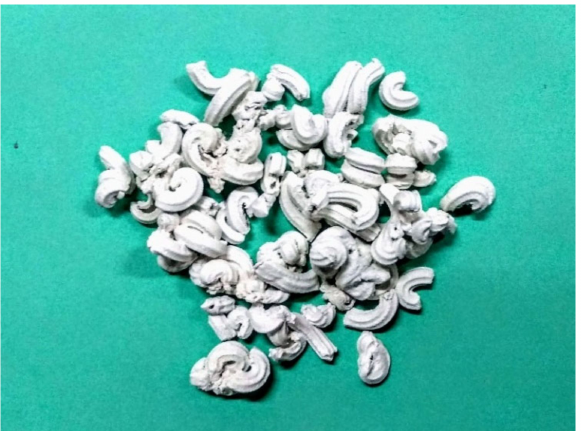
Figure 1. The appearance of the granular microbial preparation used in the